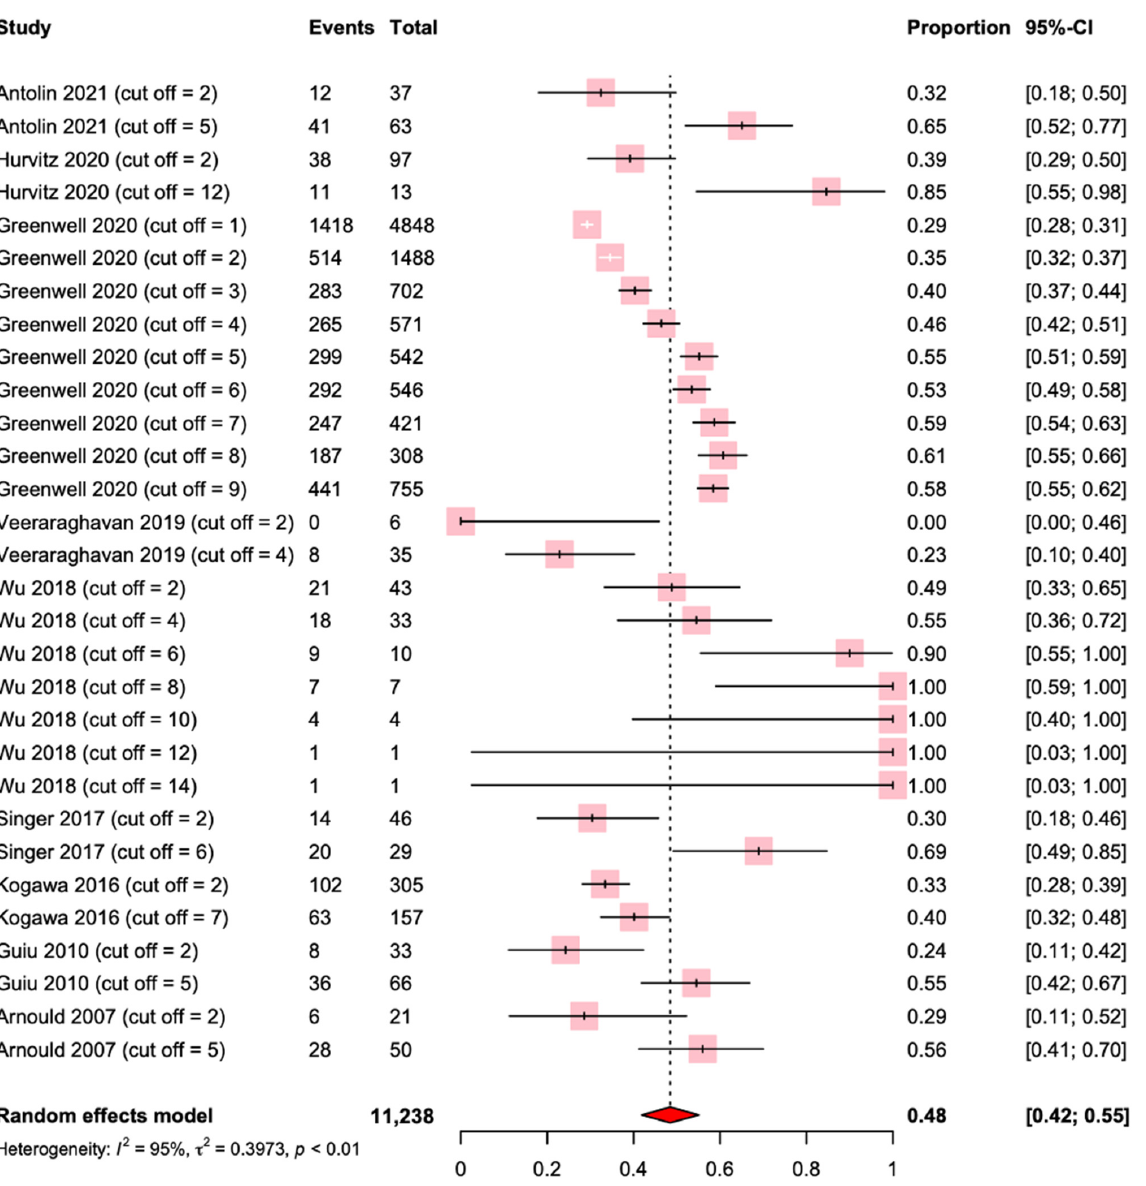
Figure 3. Forest plot for pathological complete response among the nine studies. “Event” refers to the number of patients with a pCR for a determined HER2/CEP17 ratio. “Total” refers to the total number of patients for the same HER2/CEP17 ratio. In this case, for the same study, several HER2/CEP17 ratio thresholds were considered [31,33–40].